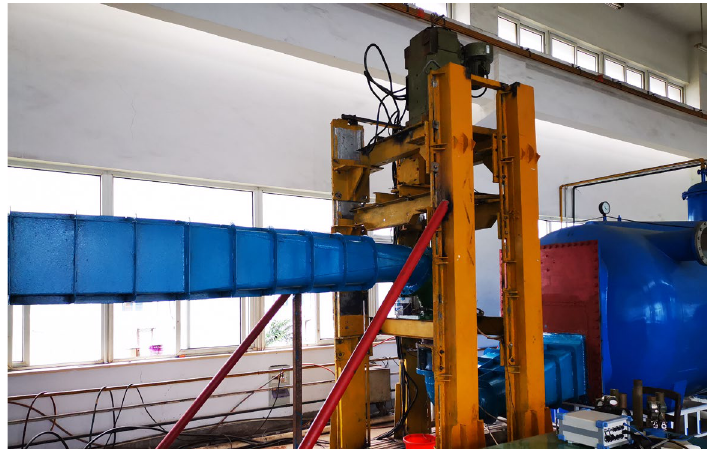
Figure 7. Model experiment of the LAPS.